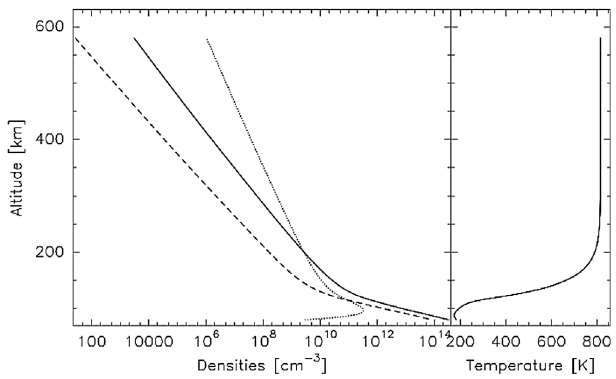
Fig. 3. The left panel shows the logarithm of the primary electron production (cm (cid:3) 2 s (cid:3) 1 ) as a function of the total solar irradiance wavelength (nm) and the altitude (with the color code in the scale on the right side). The right panel is the integration over all wavelenghts.